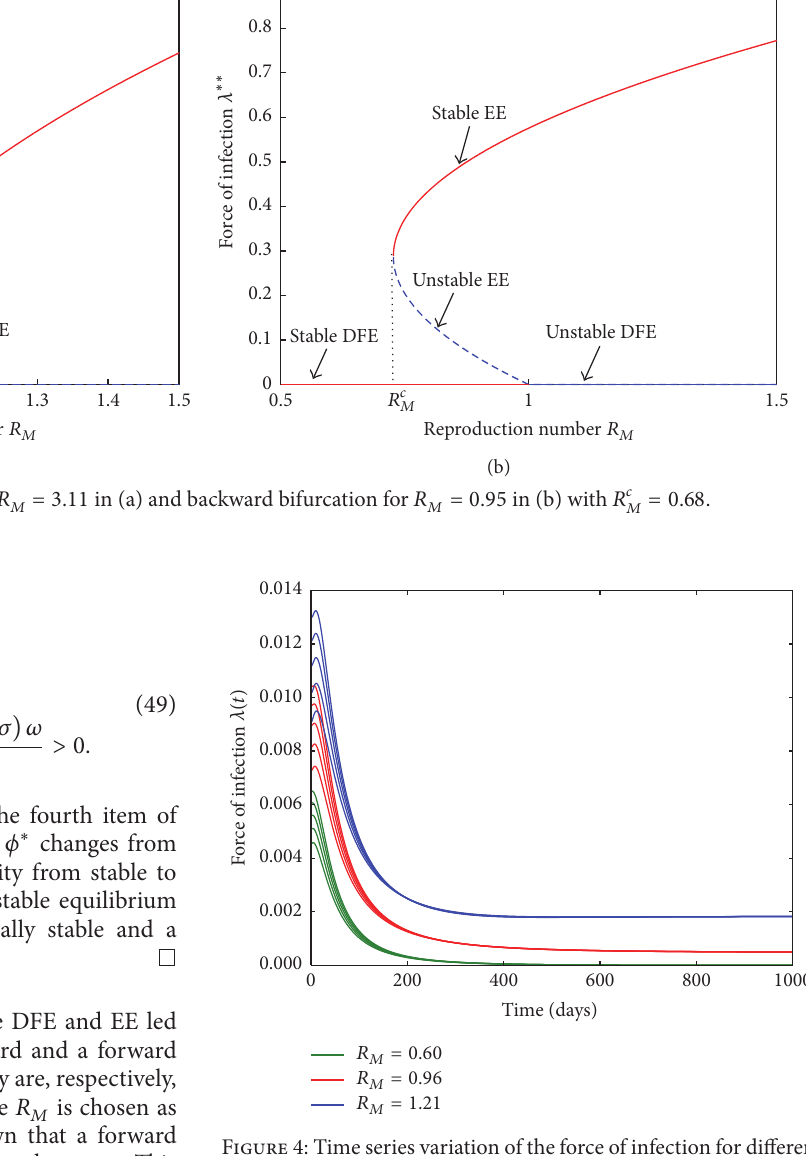
Figure 4: Time series variation of the force of infection for different values of the reproduction